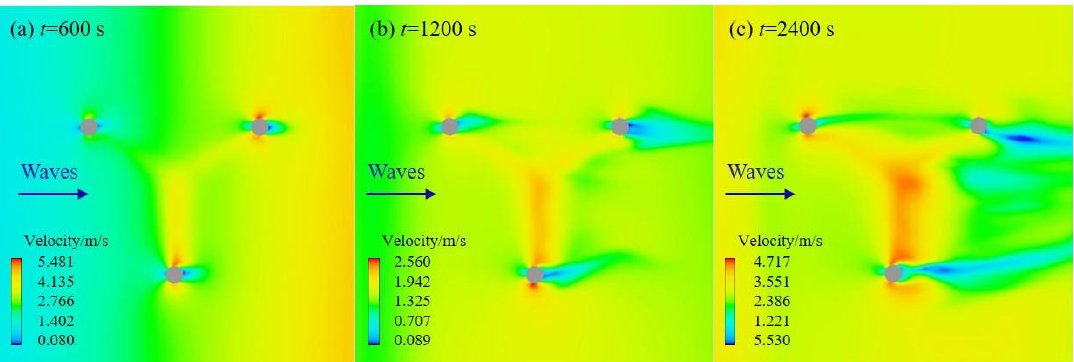
Figure 6. A sequence of scour morphologies around the tripod in case 3.